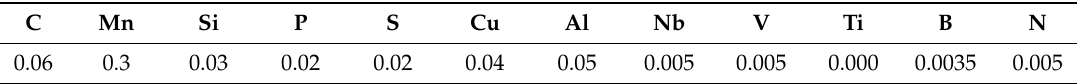
Table 1. Elemental composition of boron-bearing low-carbon steel (wt.